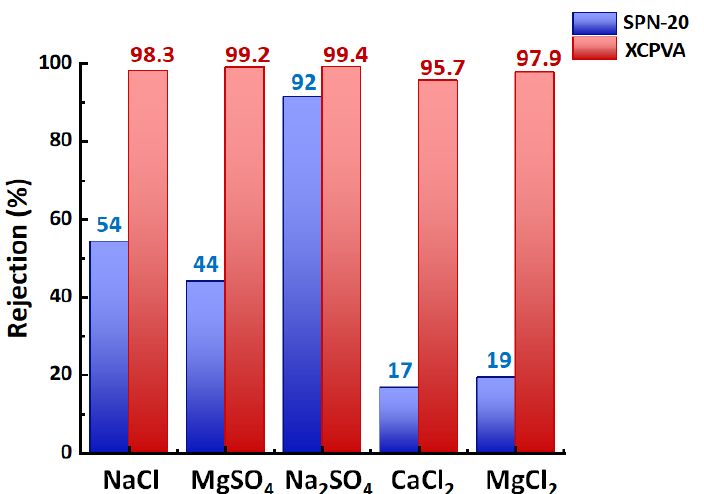
Figure 10. Salt separation performance of hollow-fiber membranes before and after CPVA adsorption and cross-linking (XCPVA). The feed pressure and temperature were 5 bar and 25 ◦ C. Salt concentra- tions were 1500 mg/L. Pure water permeances of the SPN-20/PPO membrane and XCPVA-modified membrane were 3.9 L · m − 2 · h − 1 · bar − 1 and 0.24 L · m − 2 · h − 1 · bar − 1 ,